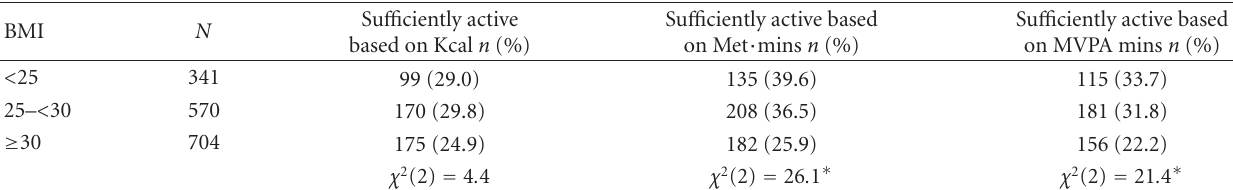
Table 3: Proportion of adults classified as “su ffi ciently” active based on the three methods stratified by BMI.